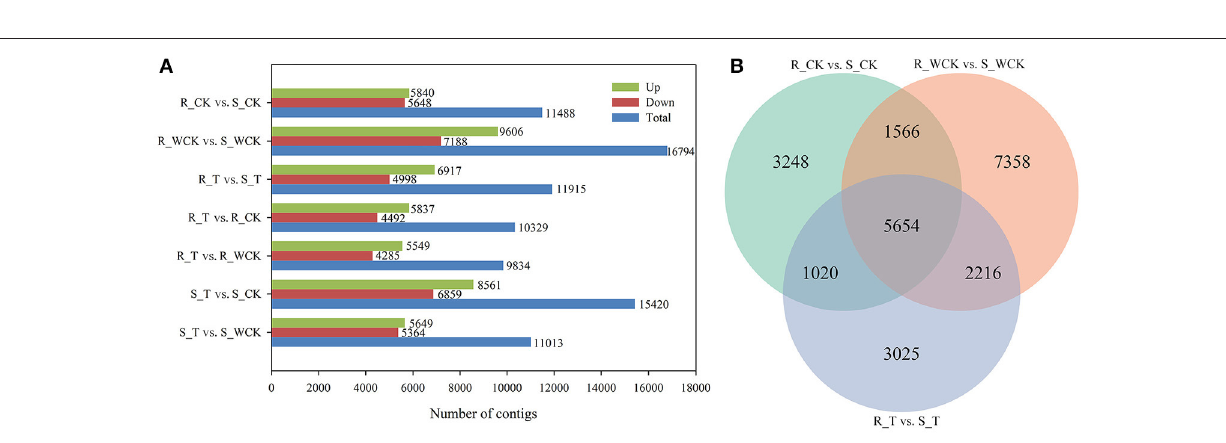
by qRT-PCR were consistent with the RNA-Seq expression data, thus revealing little deviation in the fold change ( Figure 8